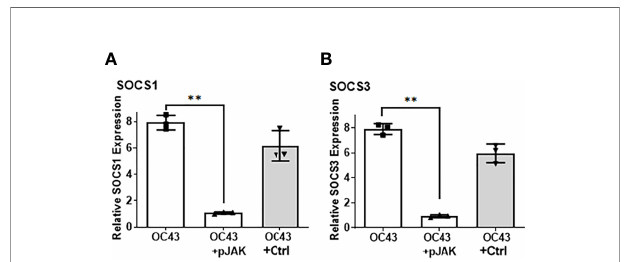
FIGURE 4 | Infection with HuCoV-OC43 induces SOCS1 and SOCS3, which is blocked in the presence of pJAK2 peptide. RD cells were pre-treated with pJAK2 or its inactive control peptide (both at 30 m M) for one hour followed by infection with HuCoV-OC43 at MOI of 0.1 for one hour. The virus was washed and taken in low serum medium and the same concentration of peptides were added to the cells and incubated for 24 hrs. RNA was extracted and used for qPCR with primers for SOCS1 (A) and SOCS3 (B) . Human b -actin primers were used to calculate relative expression of SOCS1 and SOCS3. (**p <0.001).